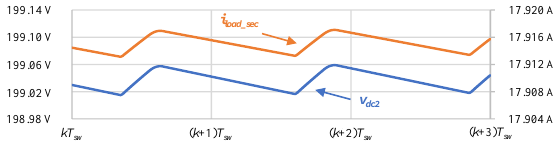
Figure 8. Voltage and current waveforms in the secondary side resistive load using SPS modulation.